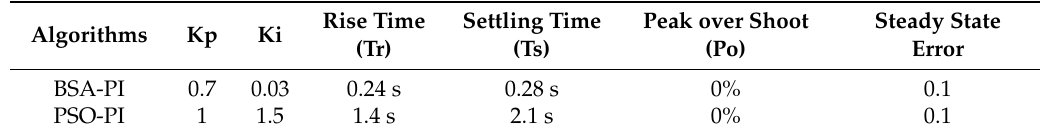
Figure 13. Experimental results PSO-PI and BSA-PI controller with respect to rise and settling time. Table 6. Comparison results obtained using BSA-PI and PSO-PI controllers.